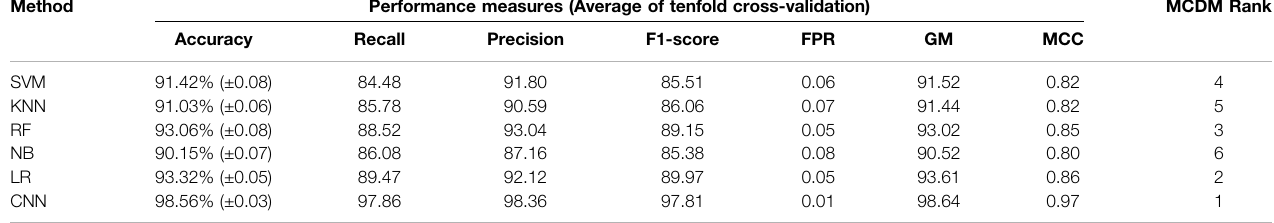
TABLE 1 | Models performance and ranking for transcriptome data. Method Performance measures (Average of tenfold cross-validation)